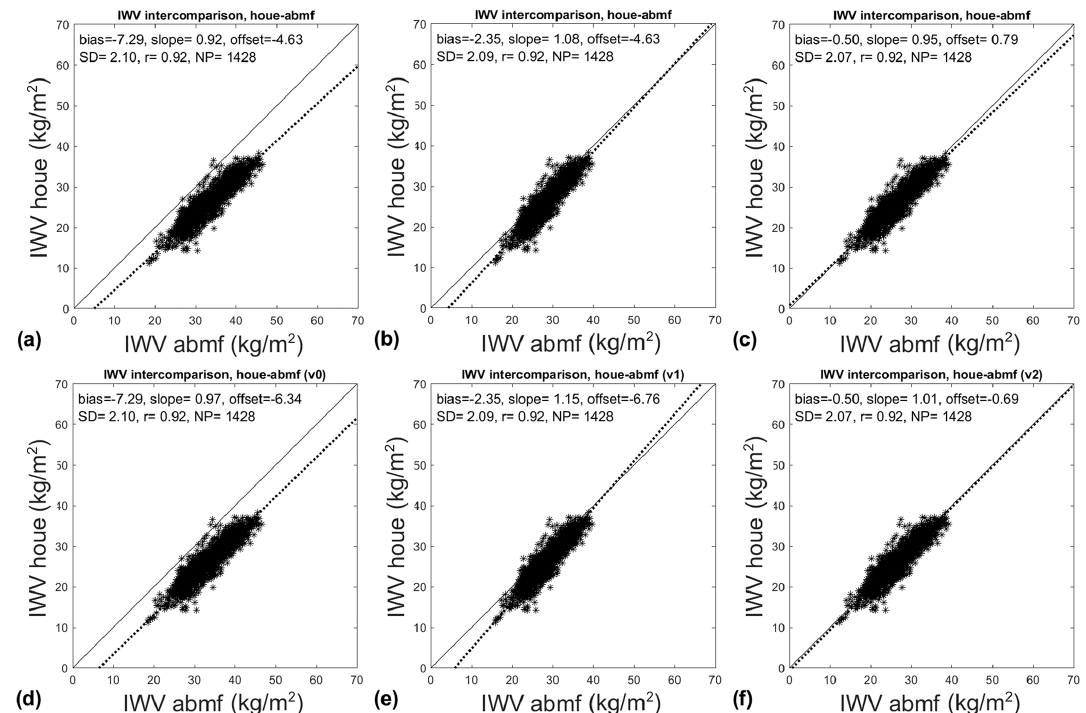
Figure 7. Scatter plots of IWV observations from two GPS stations at different elevations (HOUE, 418m, and ABMF, 15m) before correction (a, d) , after correction with a simple scaling factor model (b, e) , and after correction with the proposed model fitted from a radiosonde climatology (c, f) . The slope and offset parameters were either fitted by an ordinary least-squares method (a–c) or by the York et al. (2004) method accounting for errors in both coordinates (d–f) . The data cover the period from 1 January to 29 February 2020, with a temporal resolution of